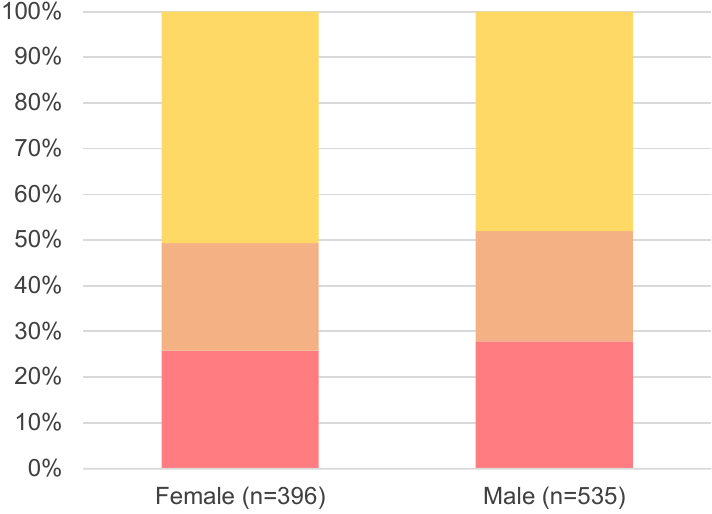
Figure 16 and Figure 17 break down the fingerspelling tokens across the nativisation model by gender. The percentage of tokens per nativisation category does not appear at first glance to vary substantially by gender.